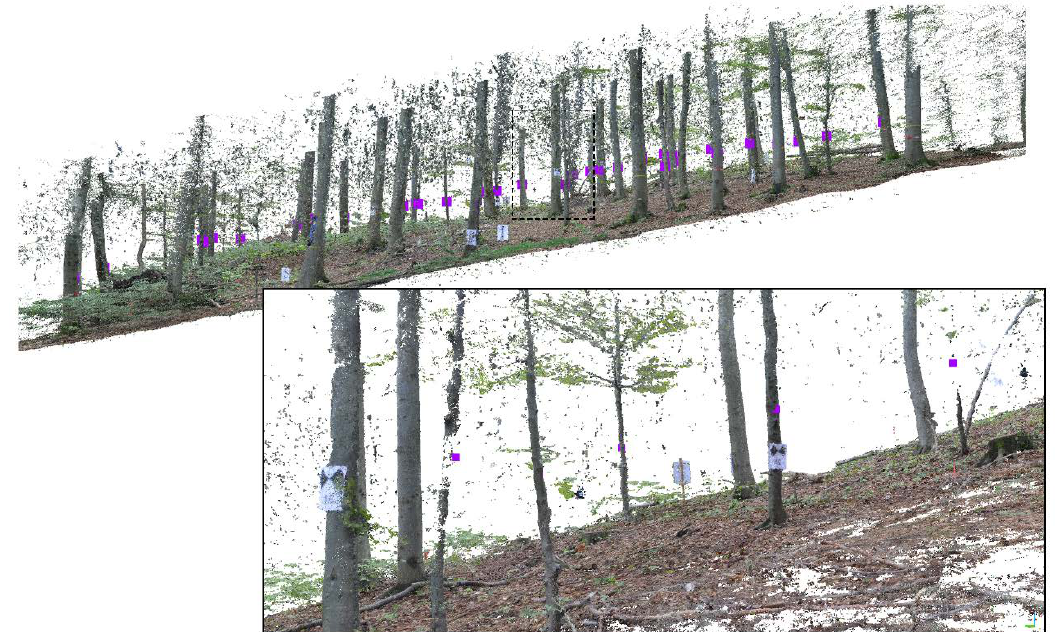
Figure 6. Coloured SfM point cloud of plot 2 in Austria, overlaid with the location of the trees measured by the total station (the magenta square dots). The dashed line indicates the location of the enlarged point cloud at the bottom.